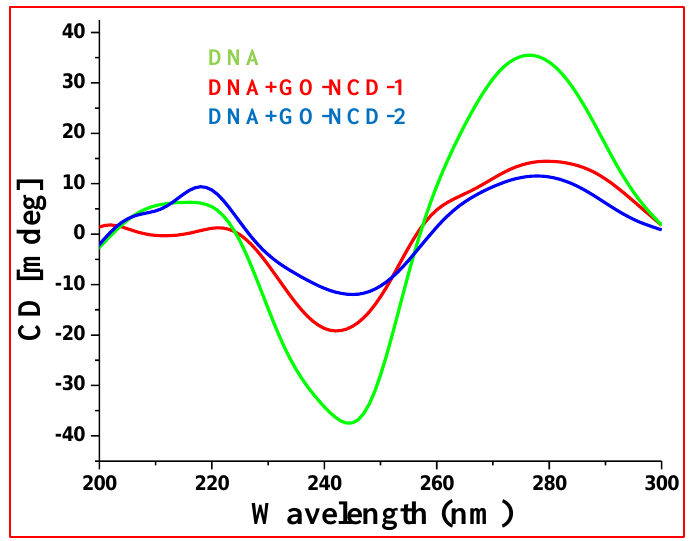
Figure 9. Circular dichroism spectra of ( a ) GO-NCD- 1 and ( b ) GO-NCD- 2 with DNA. DNA condensates of both the GO-NCD- 1 and GO-NCD- 2 were prepared, and the changes in the morphology upon interaction with ct-DNA were studied by employing the SEM. Since transition metals are charged species, they can induce DNA condensation in vitro and change the morphology of DNA into bundles, rodlike shapes, toroids, charged globules, and segregated chains, depending upon solution conditions (Figure 10). The results suggested that interaction of the DNA molecules upon condensation with nanocon- jugates resulted in the formation of globular structures, which indicated the presence of charged surfaces